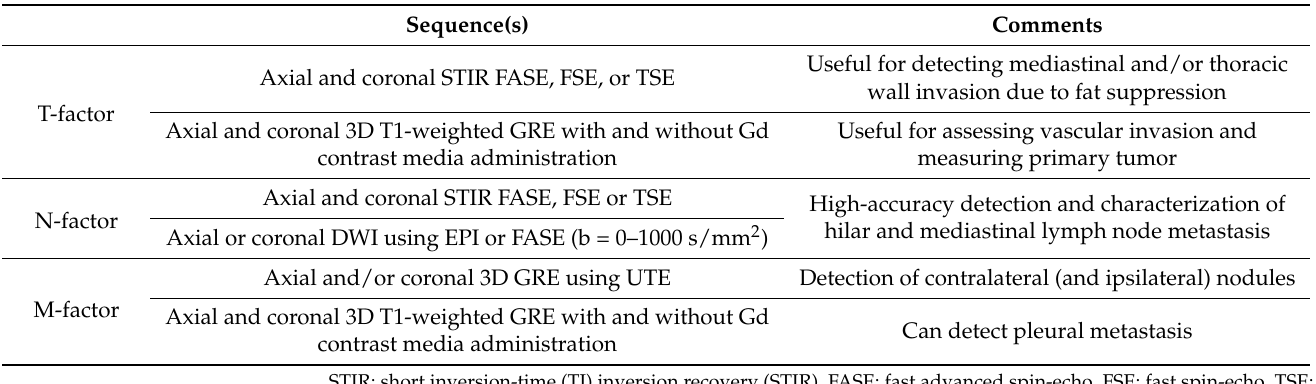
Axial and/or coronal 3D GRE using UTE Detection of contralateral (and ipsilateral) nodules Axial and coronal 3D T1-weighted GRE with and without